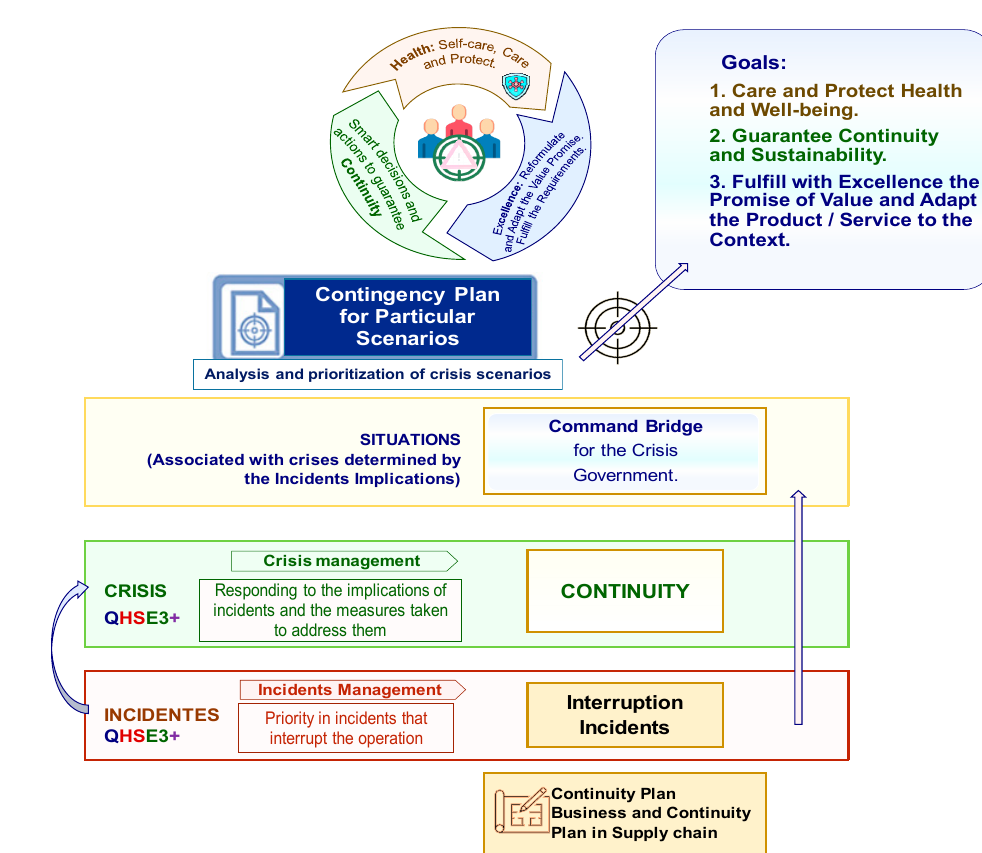
Figure 4. Crisis and Incident Management, and Business Continuity [65,66].